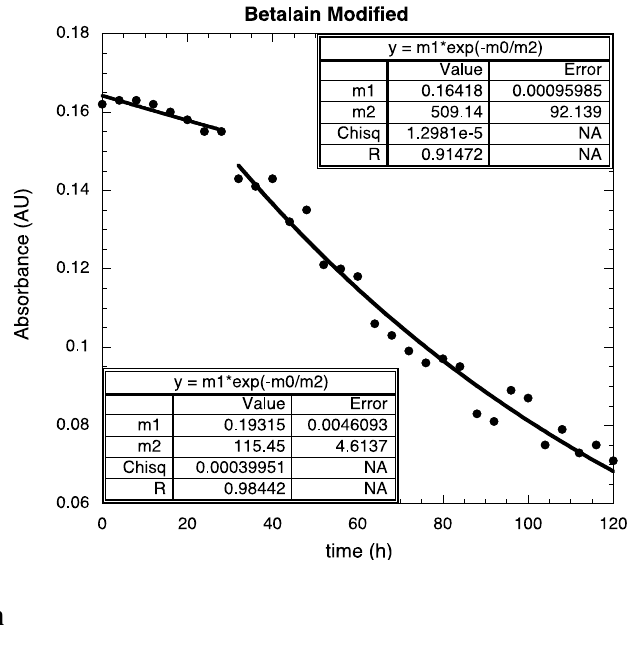
Figure 8. Detail of the Figure 7d for modified Betalain when the experimental data was fitted using a single exponential function for each of the two regimes: from 0 to 28 h and from 32 to 120